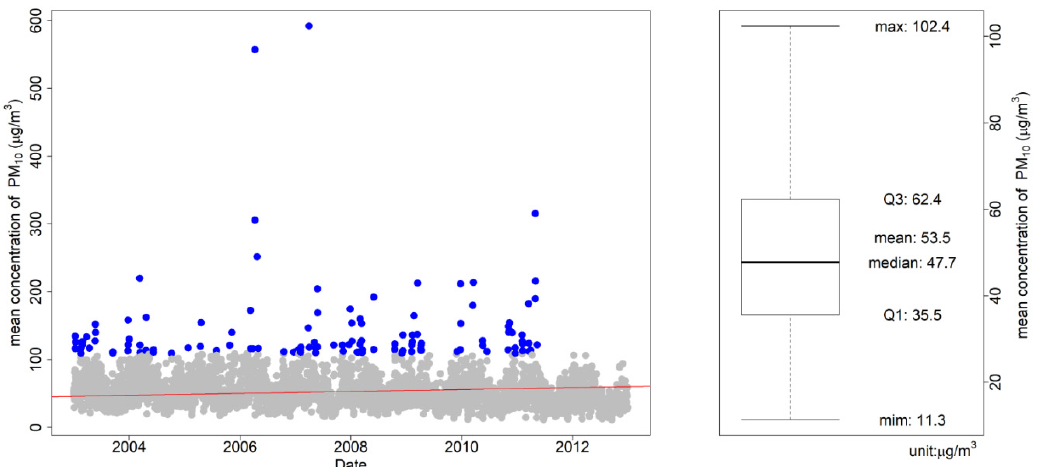
Figure 1. Mean PM 10 concentration distribution (grey dot) with outlier (blue dot) and its trend (red line) during the baseline period (2003–2012) (left), and the quartile concentration of the baseline period without outliers, which ranged from Q1 − 1.5 × IQR to Q3 + 1.5 × IQR (right). The relationships between temperature and mortality were non-linear for all considered PM 10